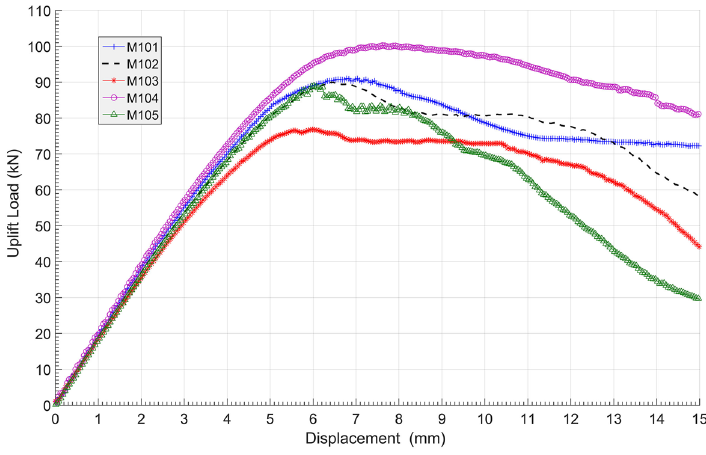
Figure 12. Load–displacement curves of group M1.